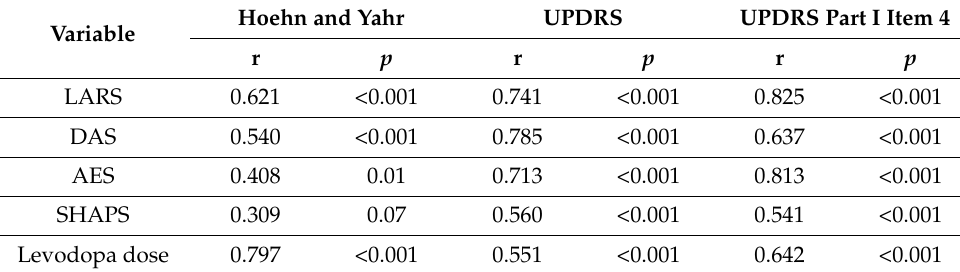
Table 2. Correlations between disease scores and apathy/anhedonia scores. Variable